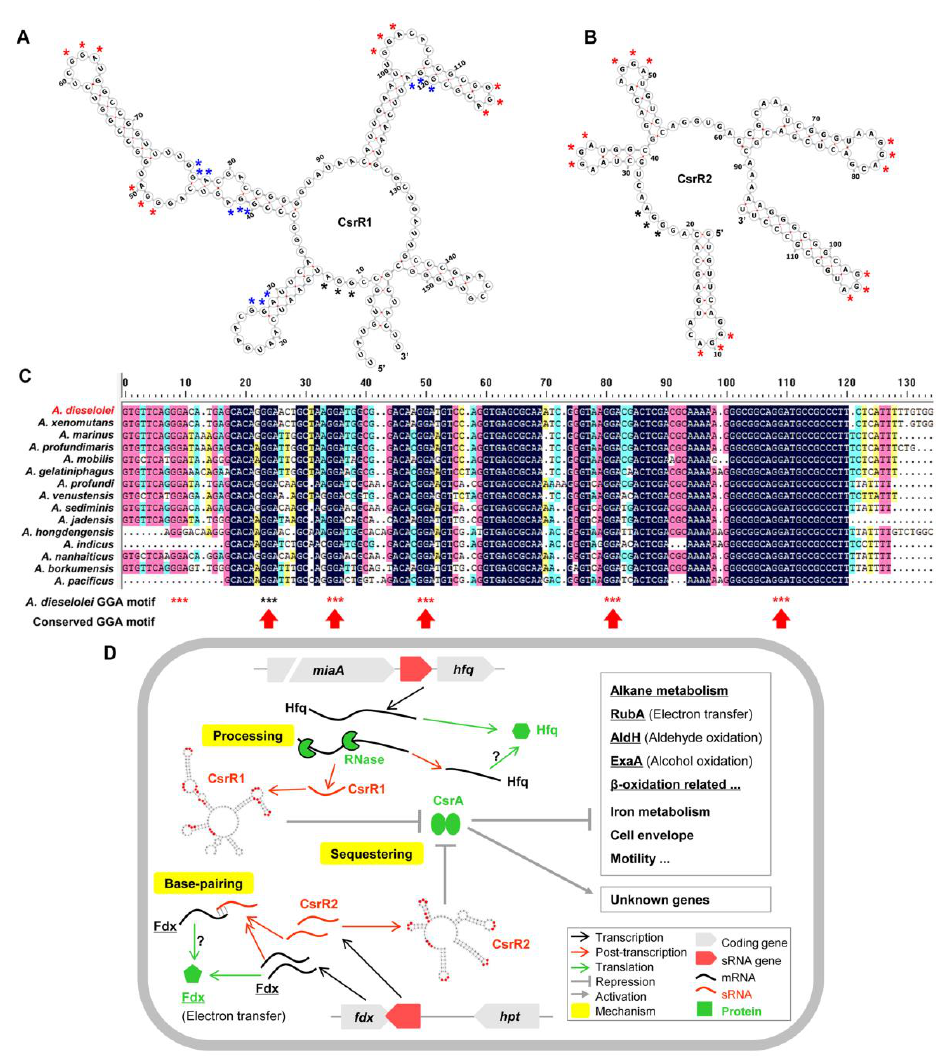
Figure 7. CsrA-related sRNAs and proposed regulation mechanisms in A. dieselolei . ( A ) and ( B ) show the secondary structures of the CsrR1 and CsrR2 conserved regions, respectively. ( C ) The alignments of CsrR2 homologous sequences in different species of Alcanivorax . The potential GGA motifs are marked using asterisks with different colors, red for motifs in loops, black for motifs in single-strand regions and blue for motifs at the junctions of the stem-loop. Secondary structures were calculated using RNAfold, and sequences were aligned with DNAMAN (version 8.0). ( D ) The proposed regulation mechanisms of the two CsrA-related sRNAs in alkane metabolism. The detailed notes are on the bottom right corner. Abbreviations: miaA , tRNA dimethylallyltransferase (B5T_00773); hfq /Hfq, Host factor (B5T_00774); RubA, Rubredoxin-NAD(+) reductase (B5T_04349); AldH, Aldehyde dehydrogenase (B5T_00039); ExaA, PQQ-dependent dehydrogenase (B5T_01640); fdx /Fdx, Ferredoxin (B5T_03135); hpt , Hpt domain-containing protein (B5T_03136). The mRNA/protein related to alkane metabolism is underlined. The question mark represents unknown effects.